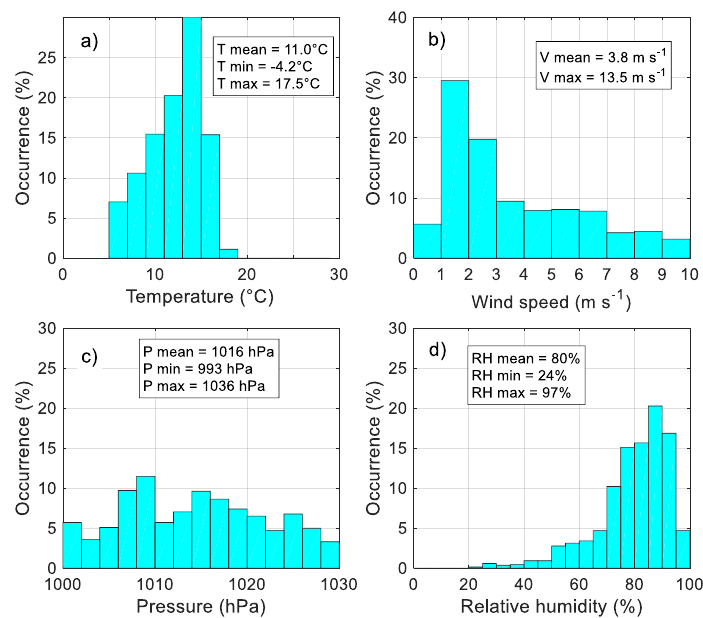
Figure 5. Histograms of ( a ) temperature, ( b ) wind speed, ( c ) pressure, and ( d ) relative humidity for the winter season of 2015–2016. Hourly averages were used to calculate the histograms.